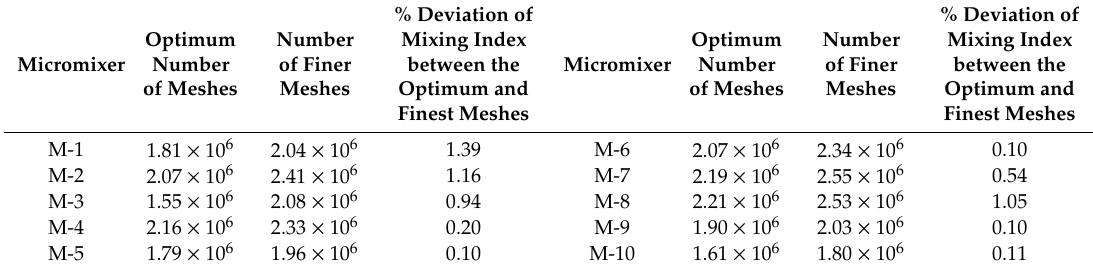
Table 3. Optimum numbers of grid nodes selected through grid refinement tests at Re =